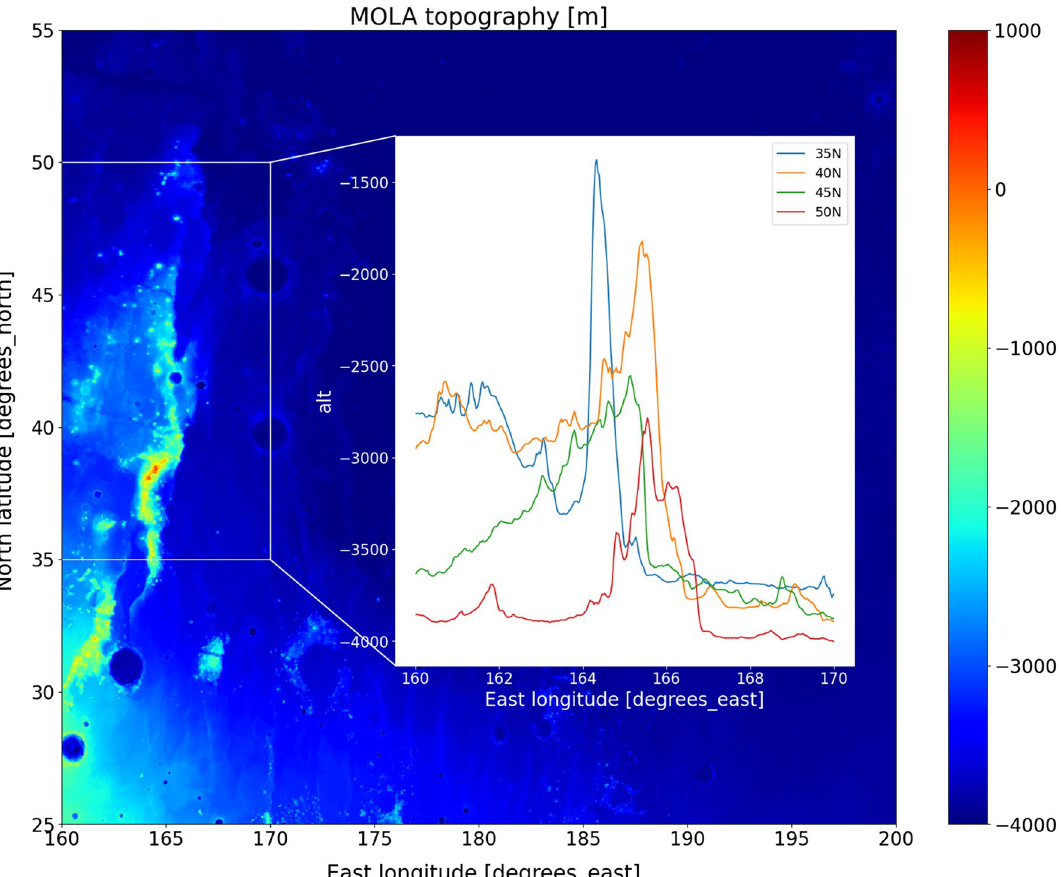
Fig. 2 Topography of the regions focused in this study. This was extracted from the topography data included in Mars Climate Database 5.0. Longitudinal distributions of the surface altitude of the Phlegra Montes at 30°N (blue), 40°N (orange), 45°N (green), and 50°N (red) are shown in the right part of the figure. 1 degree in longitude approximately corresponds to 45 km at